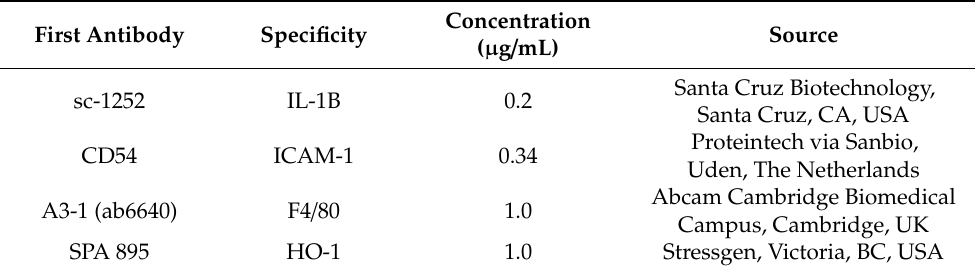
Table 1. Primary antibodies used for immunohistochemical staining for IL-1 β , ICAM-1, F4 / 80 and HO-1. Source and used concentrations of the antibodies are described.